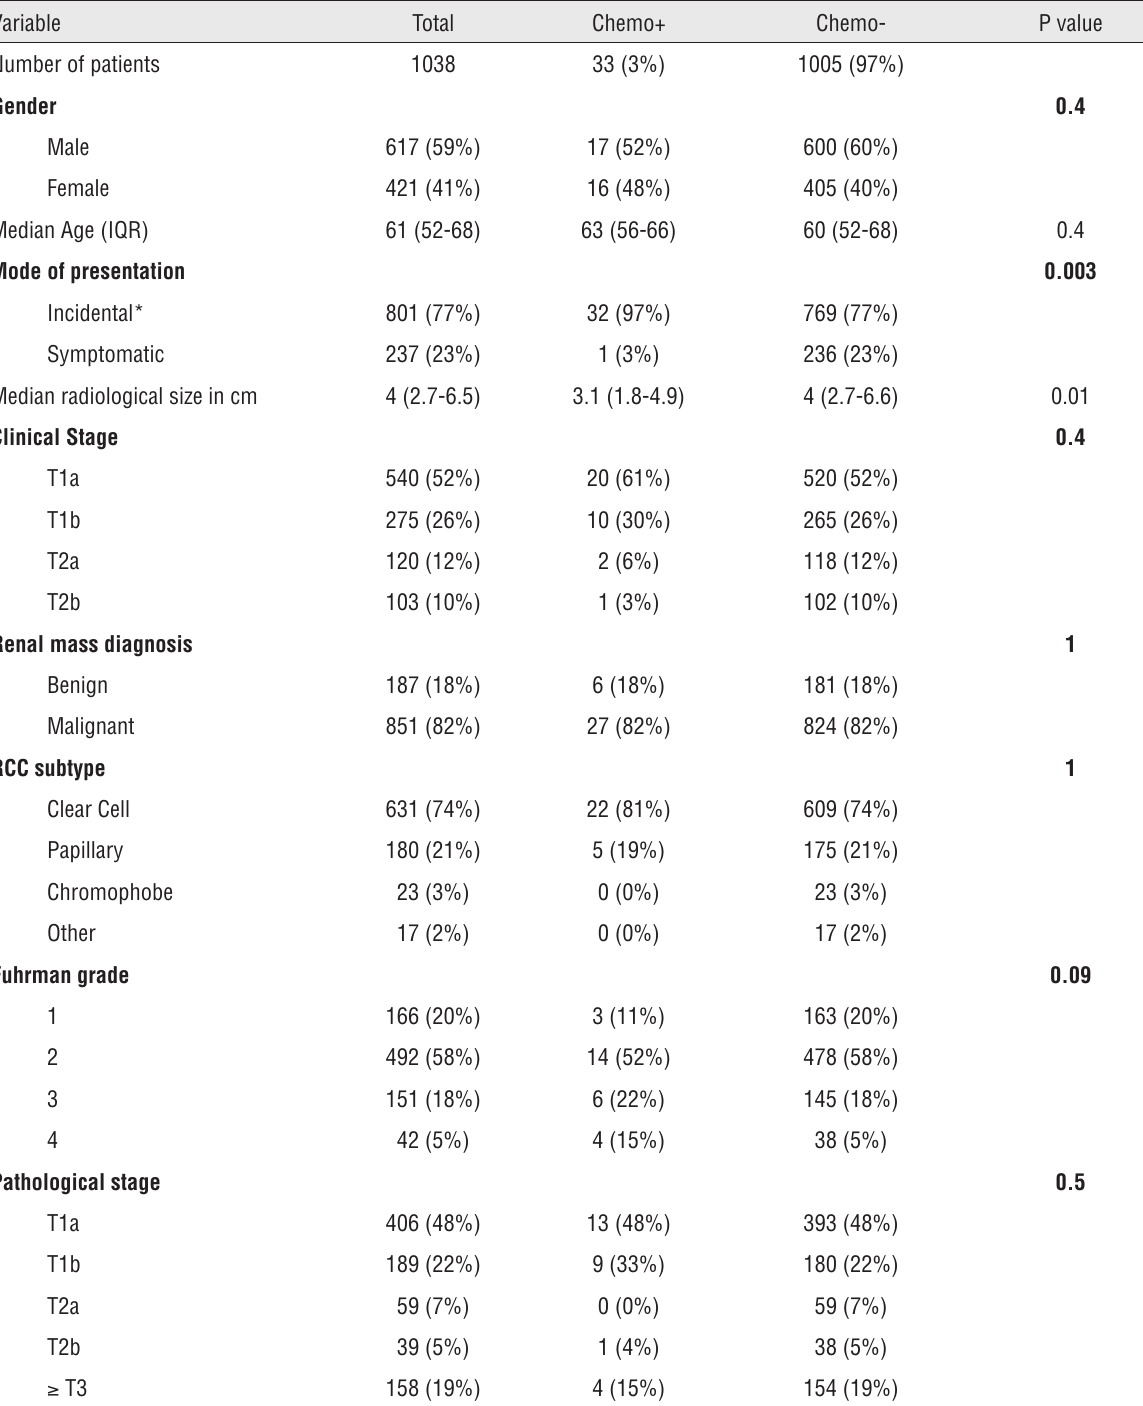
Table1 - Patient and renal mass characteristics in the total